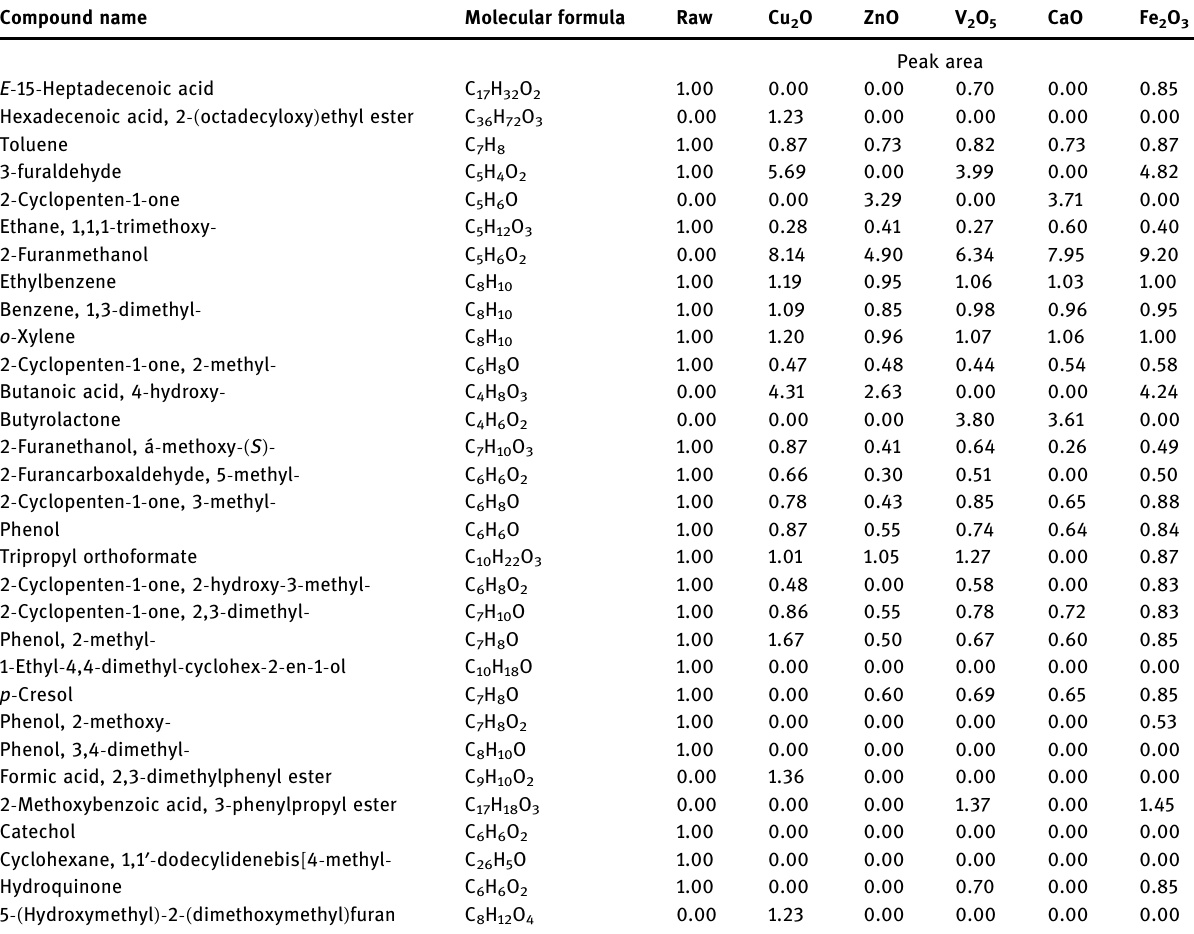
Table 5: Relative content of main components of bio - oil produced by di ff erent metal oxides at 500°C Compound name